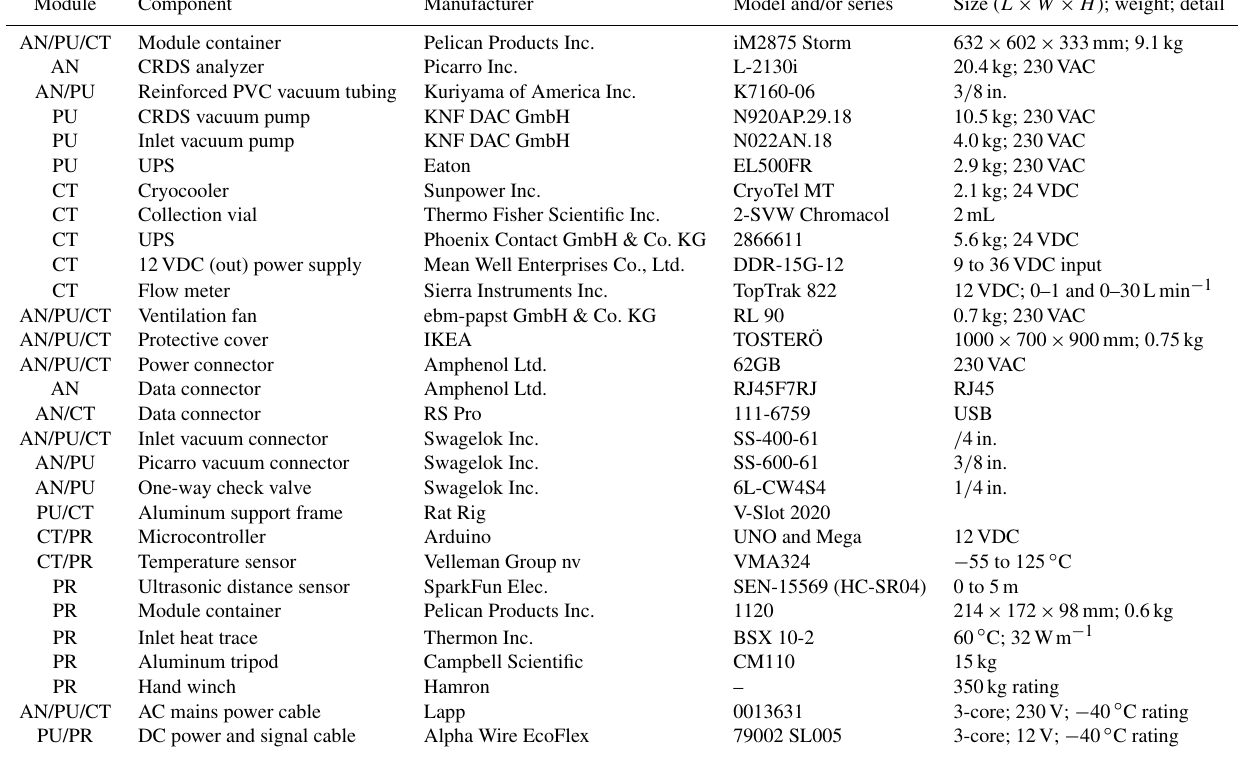
Table A1. Components used in the ISE-CUBE system. General gas connections (PTFE tubing, unions, reducers, etc.) are made with parts from Swagelok Inc. Files for 3D-printed ventilation mounts were custom-made and are not listed (see the Supplement). Modular abbrevia- tions are as follows: AN = analyzer module; PU = pump module; CT = cold-trap module; PR = profiling